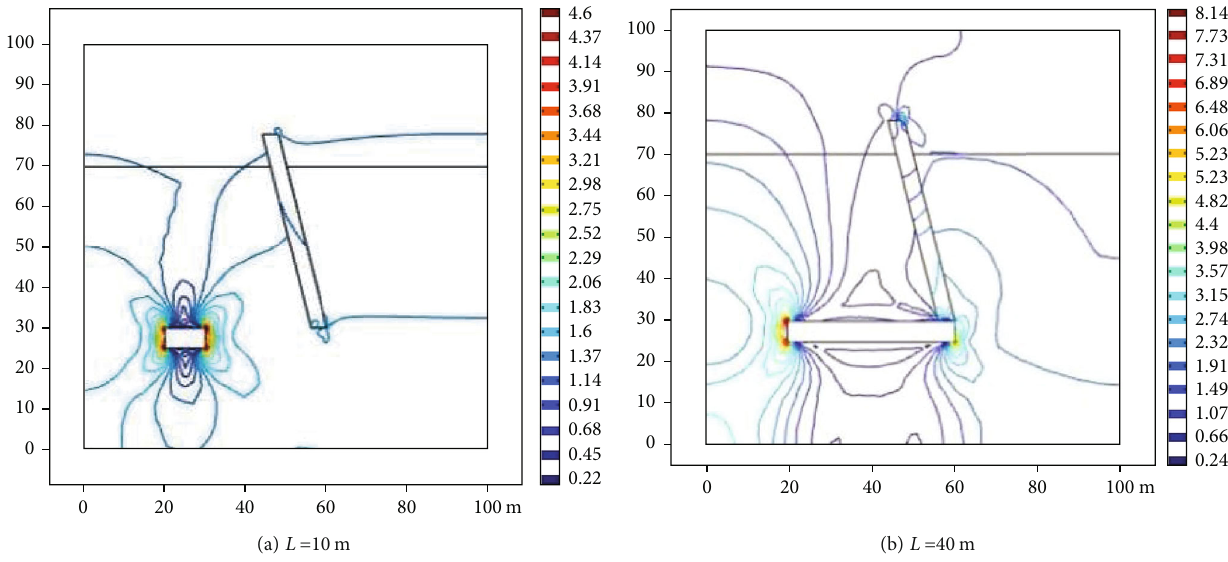
Figure 4: Contour lines of principal stress di ff erence ratio distribution in monitoring line